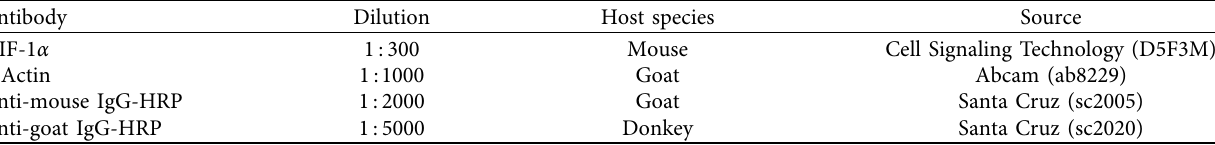
Table 1: Antibodies used to detect HIF-1 α and β -actin protein levels and primary and secondary antibodies used in WB. Antibody